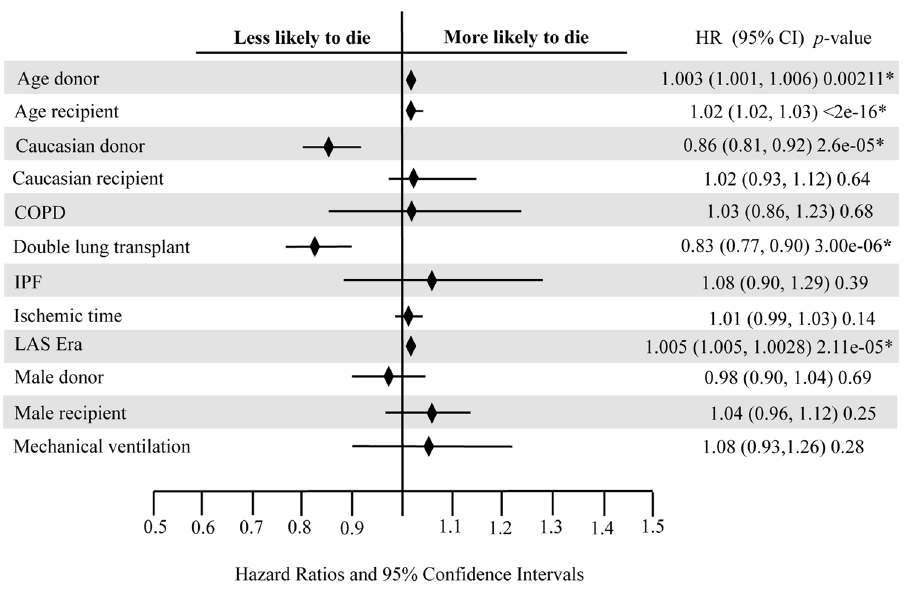
IPF group, respectively. Finally, lung re-transplant rates were relatively low but statistically significantly higher in patients with IPF. The survival analysis in the three groups showed a better survival rate for patients with sarcoidosis compared with patients with COPD and IPF ( p < 0.001, log-rank test). Figure 1 displays the significant post-transplant survival difference between sarcoidosis and the COPD and IPF groups. In Cox-regression analysis, double lung transplant and white race of the lung donor showed to have a significant survival advantage, with an HR of 0.83 (95%CI: 0.77–0.90) and 0.86 (95%CI: 0.81–0.92), respectively. Figure 2 illustrates a plot of the estimates and the 95% confidence intervals obtained from Cox regression analysis representing independent factors associated with